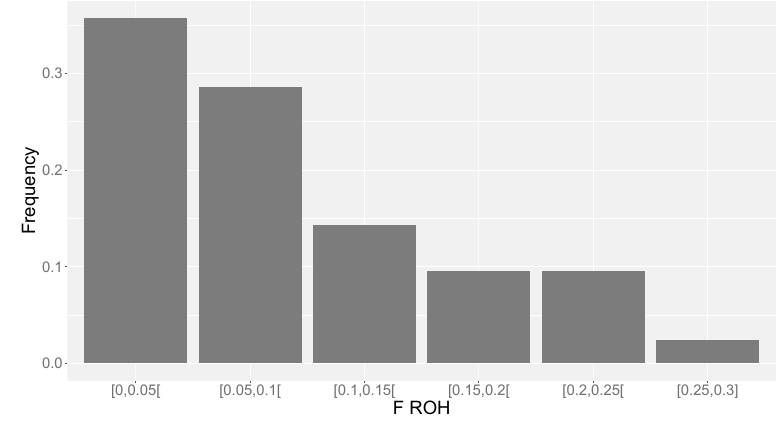
Figure 3. Distribution of F ROH estimates across animals.